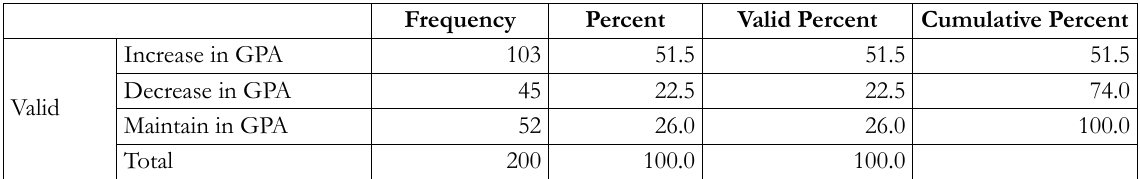
Table 3. Descriptive statistics for students’